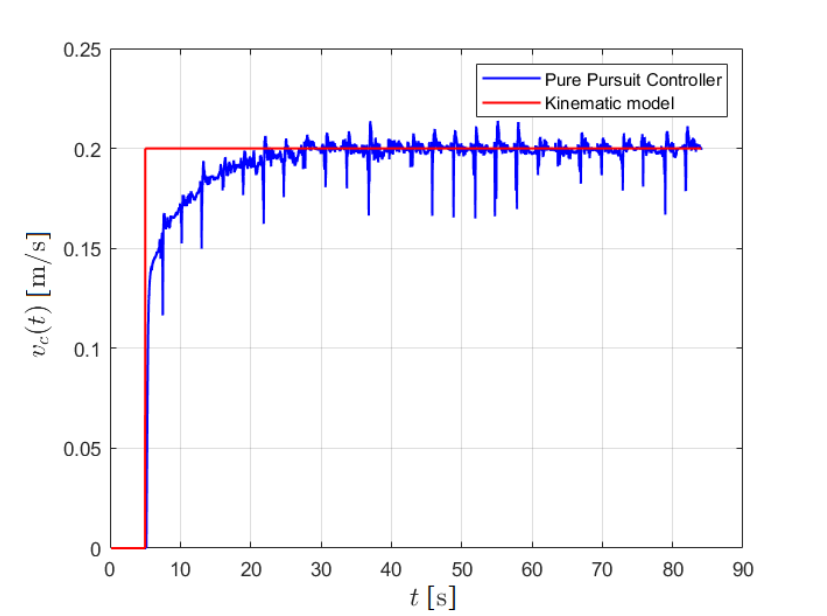
Figure 28. Linear velocity v c ( t ) of the